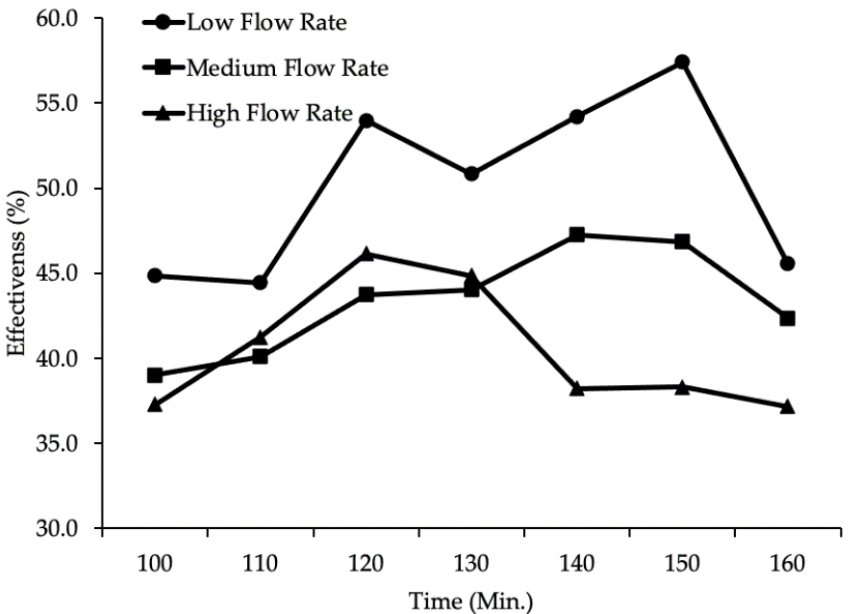
Figure 8. Effectiveness under various water flow rates on the tube side.